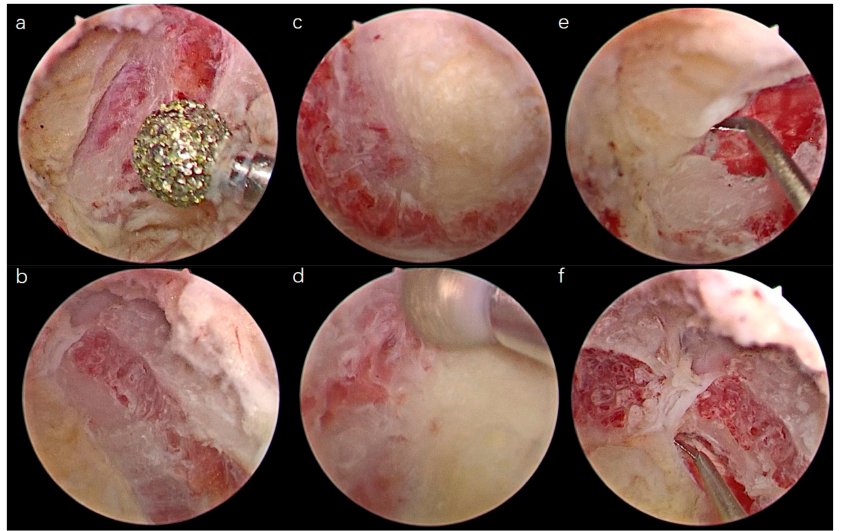
Figure 3. The ipsilateral and contralateral inferior insertion of the LF was exposed ( a , b ). The ipsilateral and contralateral superior insertion of the LF was exposed ( c , d ). The mini bush-hook was used to liberate the LF bilaterally ( e , f ).